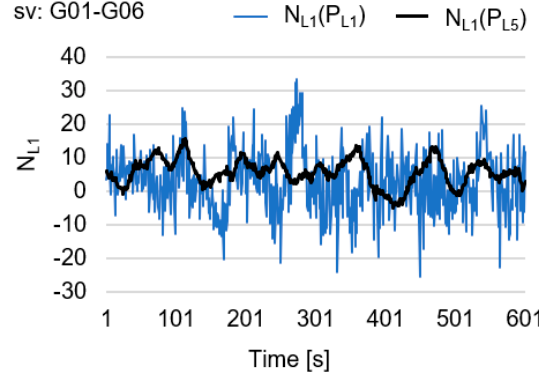
Figure 1. Time series of single-epoch double-di ff erence (DD) geometry-free float solutions N L1 with the use of P L1 and P L5 .